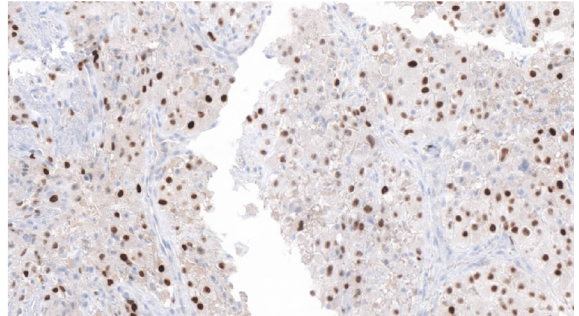
Figure 5: Vaginalmass biopsy: demonstrating positive reactivity for immunohistochemical PAX8 Stain, consistent with RCC.